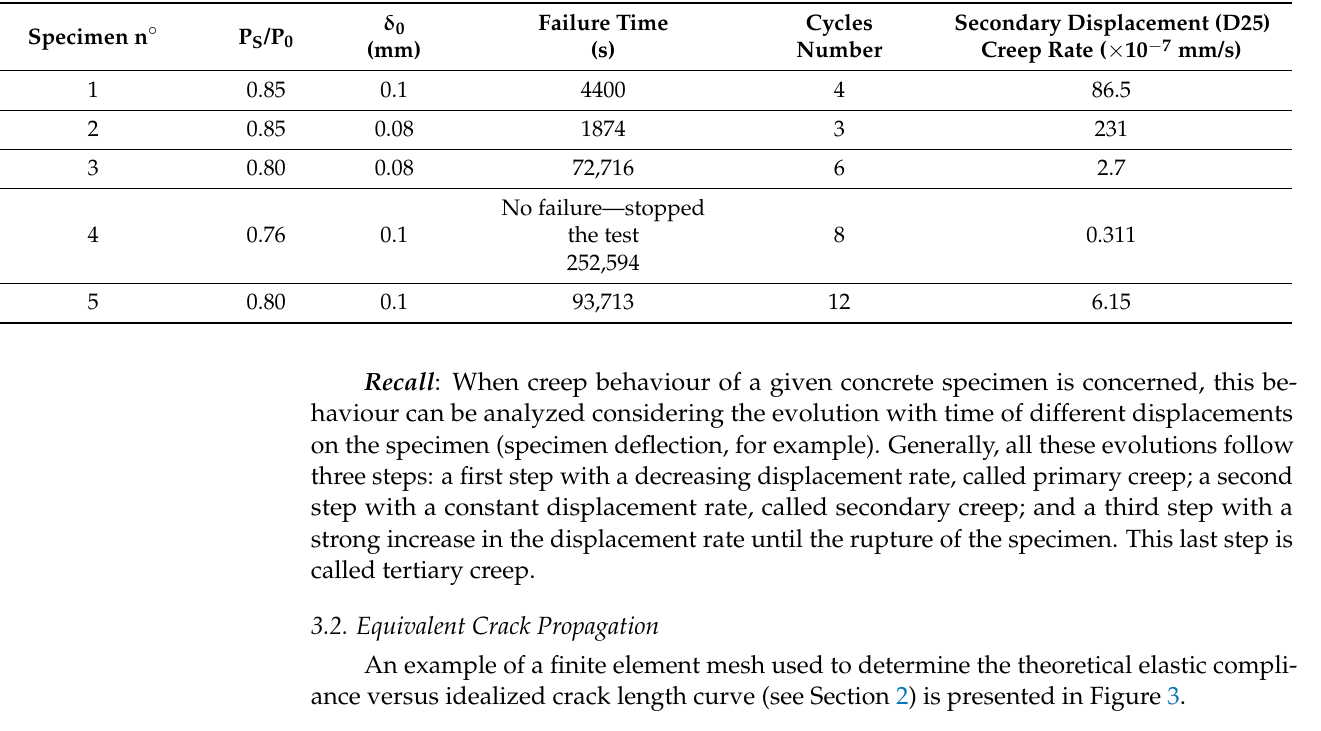
Table 1. Information about the secondary displacement (D25) creep rates related to the specimens tested.